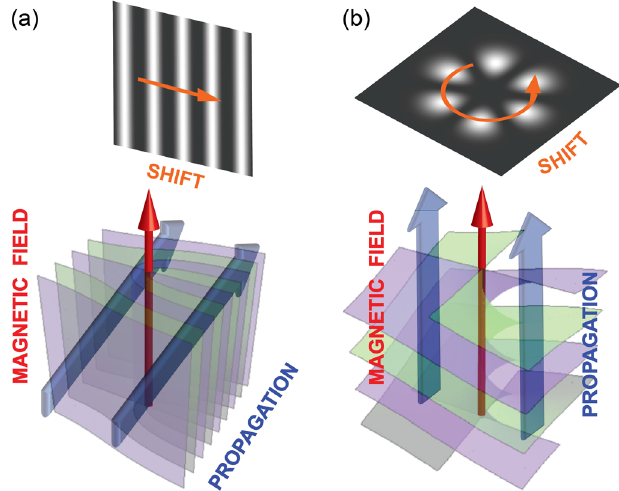
FIG. 1. (a) Standard ‘‘transverse’’ geometry of the Aharonov- Bohm and Landau problems. The electron wave propagates orthogonally to the magnetic field and shows an edge wave- front dislocation in the case of an isolated magnetic flux line. A field-induced transport (e.g., a shift of the interference fringes in the Aharonov-Bohm effect, or quantum-Hall effect) occurs in the direction orthogonal to both the magnetic field and the main propagation of the electrons. (b) In contrast, the ‘‘longitudinal’’ geometry, considered in this paper, involves the propagation of electron waves along the magnetic field. In this case, the wave fronts carry a screw dislocation, whereas the field-induced transport (e.g., a shift of the Landau interference patterns or radial Aharonov-Bohm effect) occurs in the azimuthal or radial directions. (See Figs. 6 and